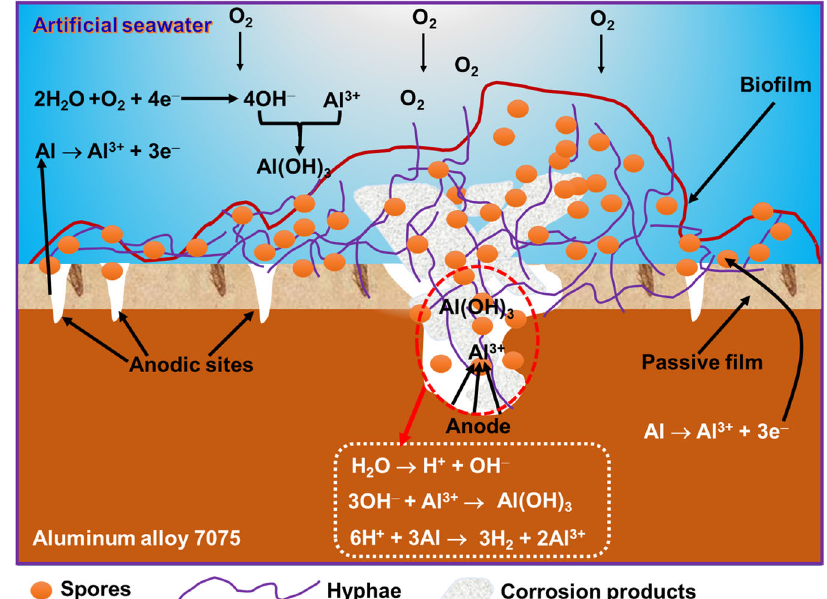
Fig. 9 Schematic diagram of localized corrosion formation mechanism. Shown for in the presence of A. terreus with continued organic carbon